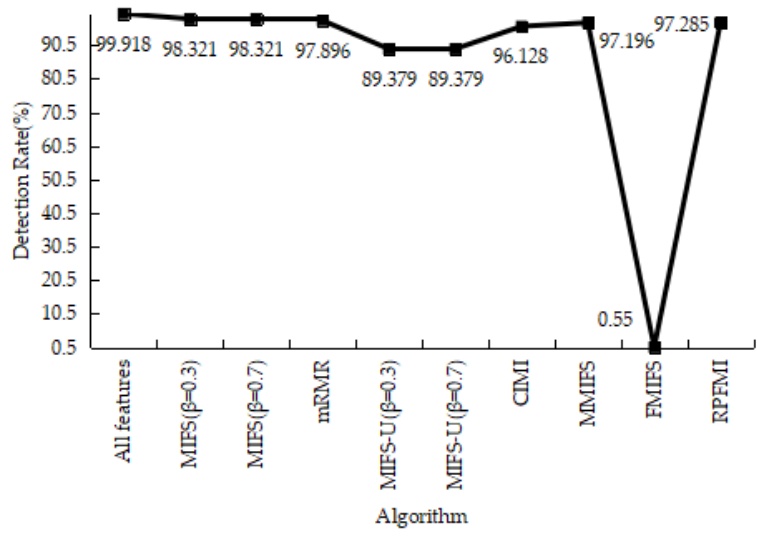
Figure 14. Detection Rate on the Kyoto 2006+ test data.